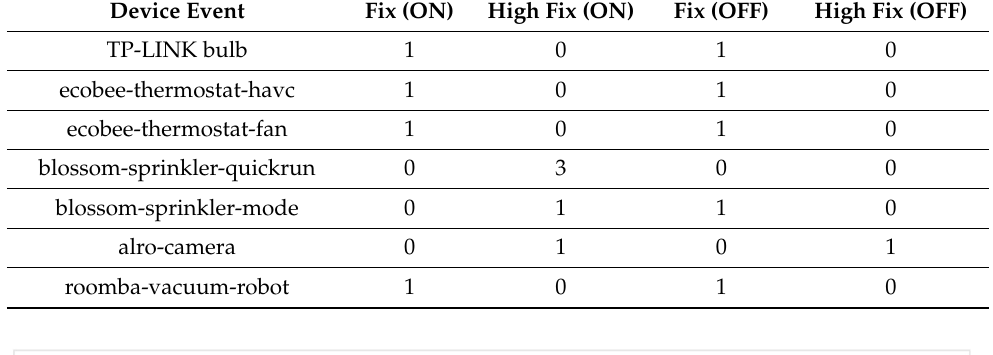
Table 10. Fix parameter adjustment.